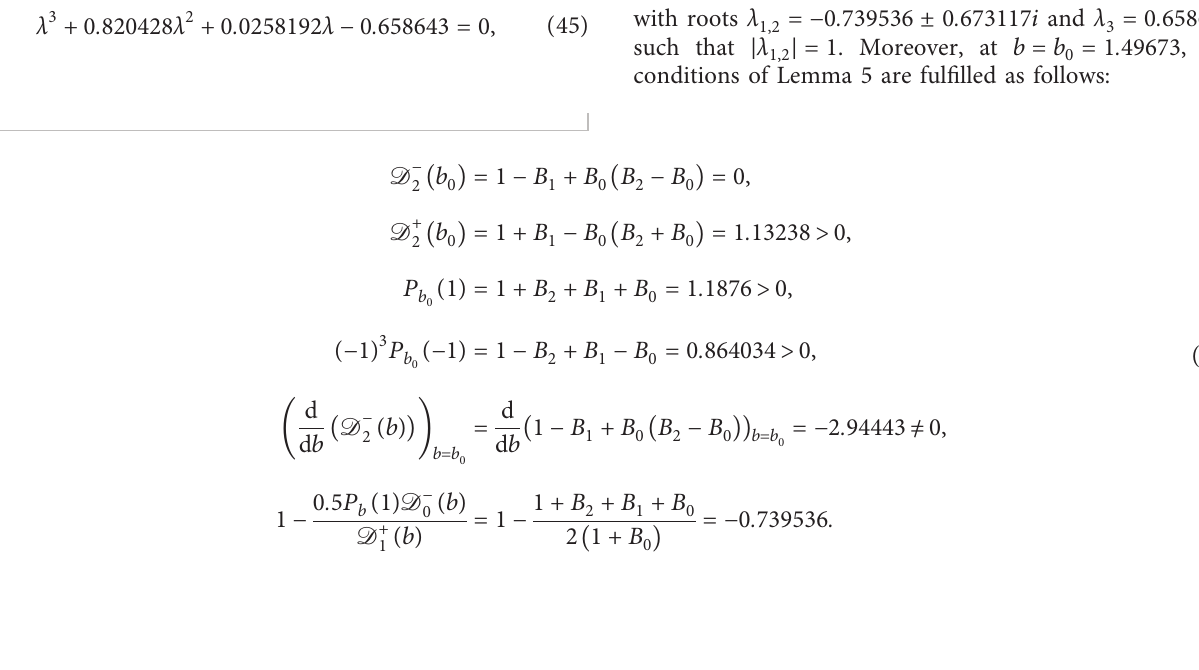
,y ,z ) � ( 0 . 458 , 0 . 206 , 25 . 75 ) . (a) Bifurcation diagram for x 0 0 0